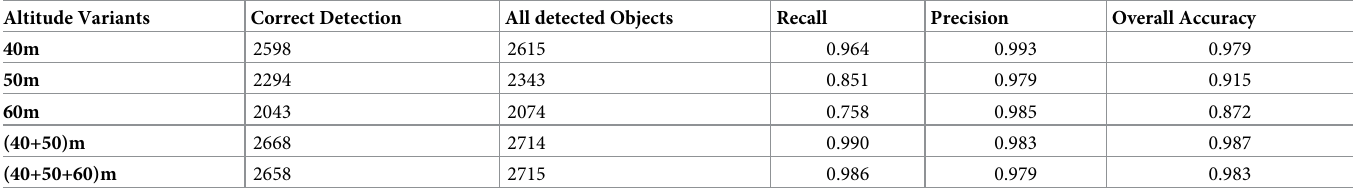
Table 8. Detection performance after combination of altitude variants.